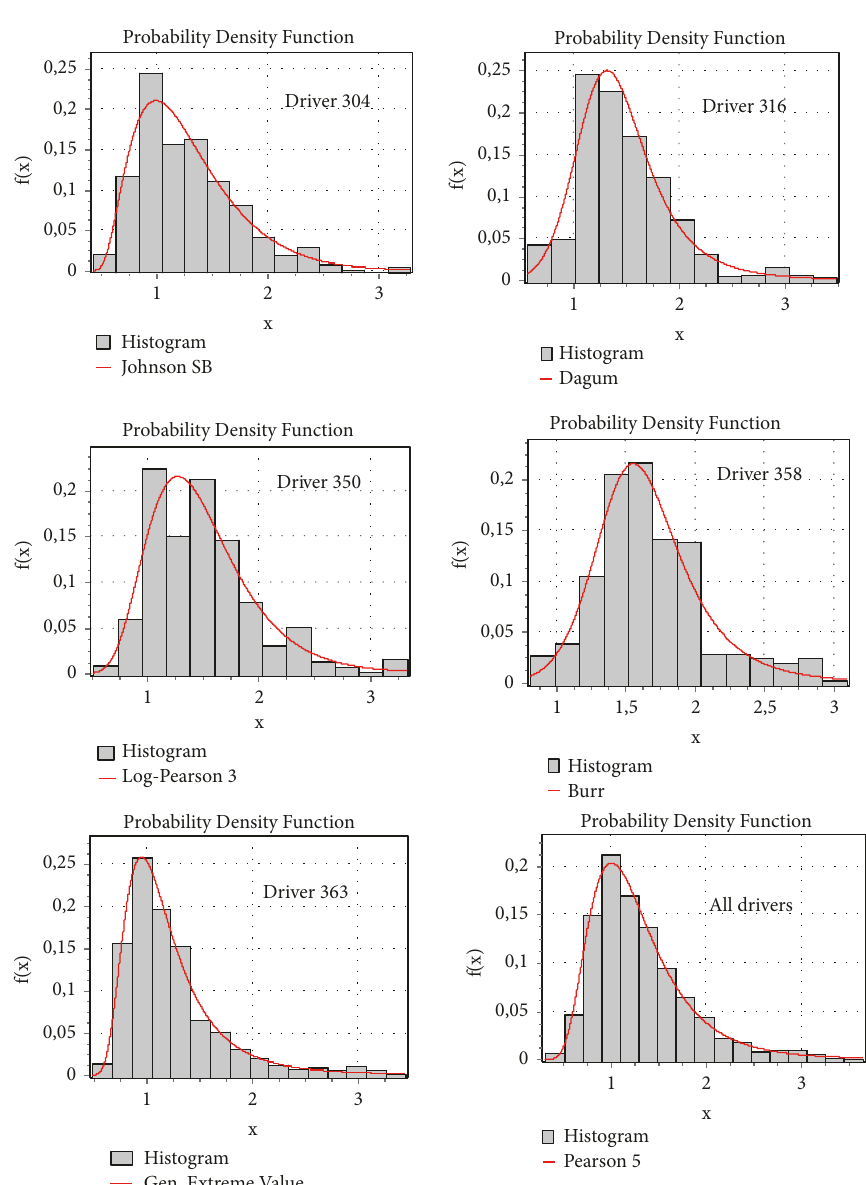
Figure 4: Statistical distributions for different drivers and all drivers combined for the speed interval [90,108[ km/h.